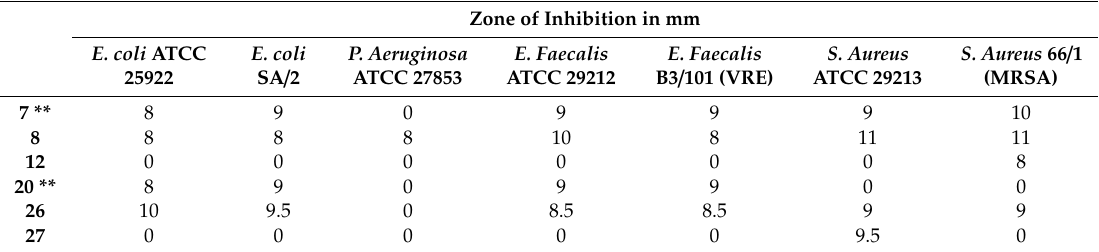
Table 5. Antibacterial activity of the compounds 7 , 8 , 12 , 20 , 26 , 27 . Inhibition halos are expressed in mm.